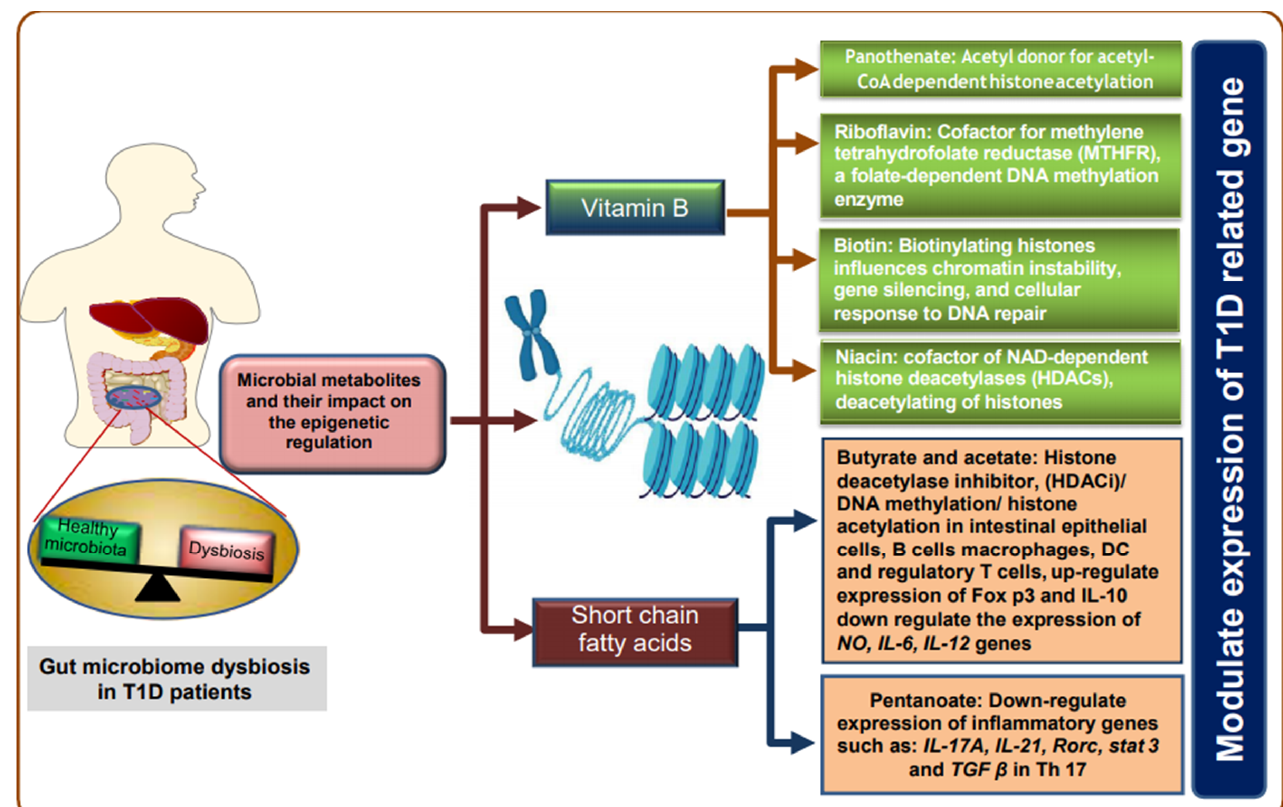
Figure 3. Role of microbial metabolites in the epigenetic regulation in T1D. Gut microbiota synthesize most of the B vitamins (Niacin, Biotin, Riboflavin, Pantothenate) that show different epigenetic roles and can modulate the expression of T1D associated genes. The therapeutic effects of SCFAs (mainly pentanoate) on autoimmune disorders are mediated by Th 17, macrophages, and dendritic cells (DC) via lowering the expression of inflammatory genes including IL-6 , IL-12 , IL-17A , IL-21 , Rorc (RAR-related orphan receptor C gene), Stat3 (Signal transducer and activator of transcription 3), nitric oxide (NO), lowering the immune response towards intestinal microbiota and enhancing the immune tolerance in the gut by T cell-independent IgA response. The figure was created using BioRender.com and Science slides